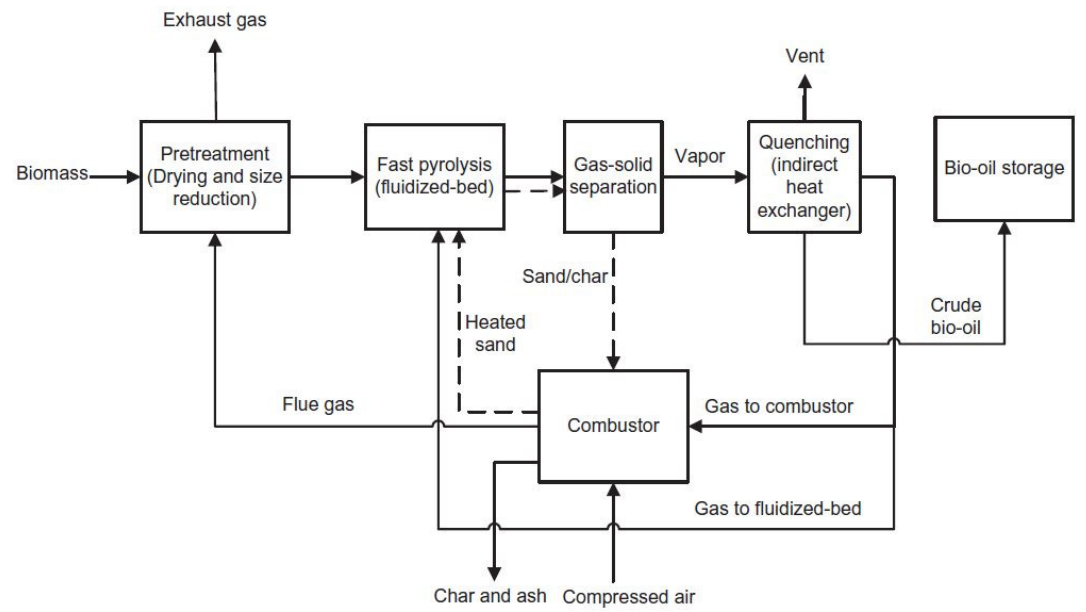
Figure 2. Schematic of auto thermal pyrolysis unit.